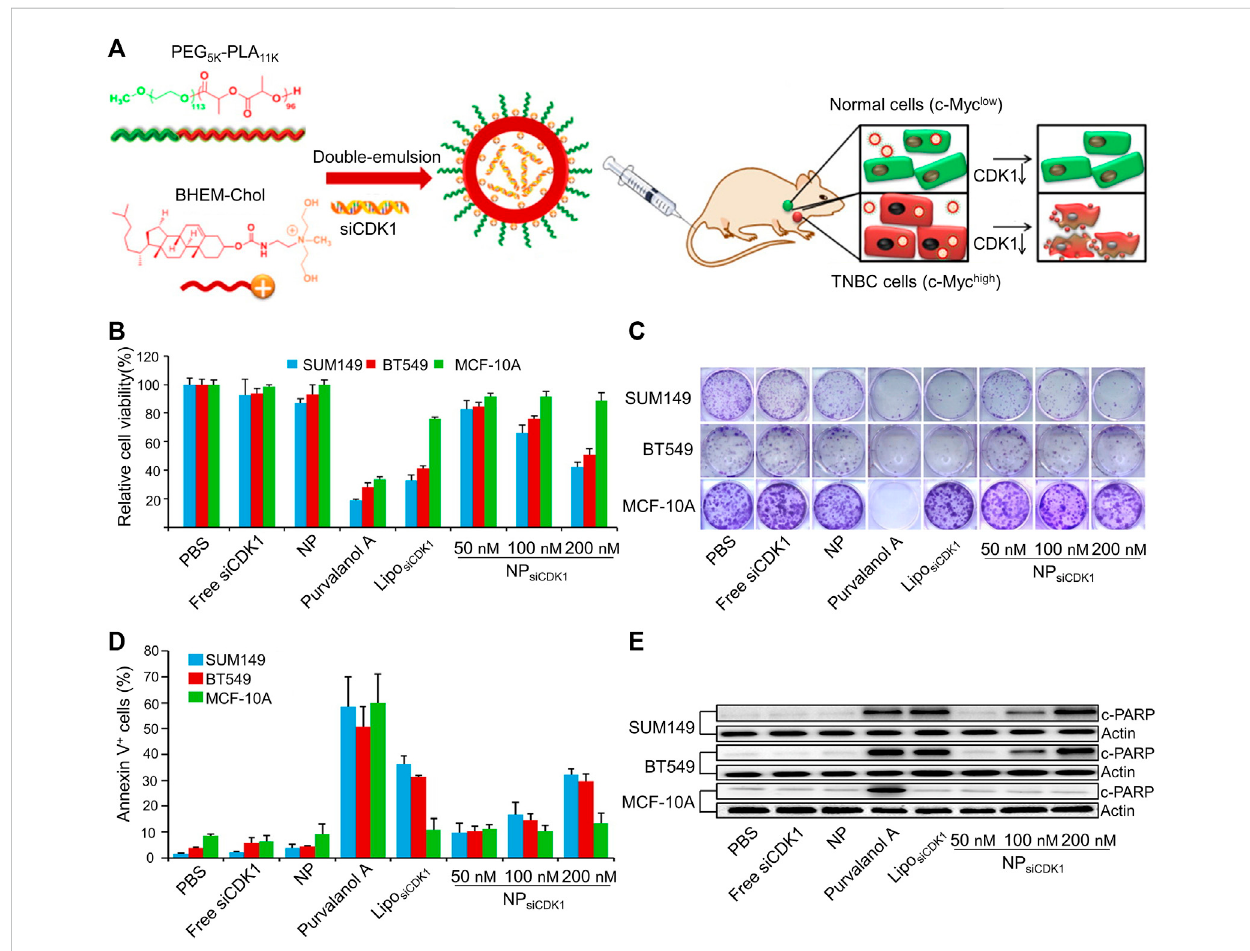
FIGURE 2 Cationic lipid-assistedPEG-PLA nanoparticlesystem delivers siCDK1 for thetreatment oftriple-negative breastcancer (TNBC) with over-expressed of c-Myc. (A) Schematic illustration of nanoparticles. (B) Cell viability and (C) colony formation of cells. (D) Cell apoptosis and (E) c-PARP expression change. Reproduced with permission (Liu et al., 2014) Copyright © 2014, Elsevier